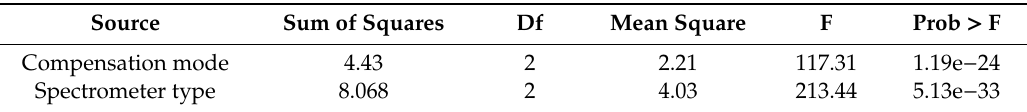
Table 3. Significance testing of compensation mode and spectrometer type on overall accuracy of the quadratic discriminant